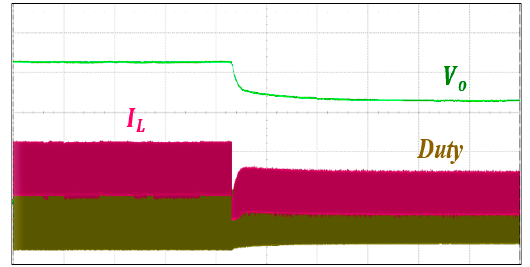
current mode control. (10 V/div, 1 A/div, 50 ms/div).